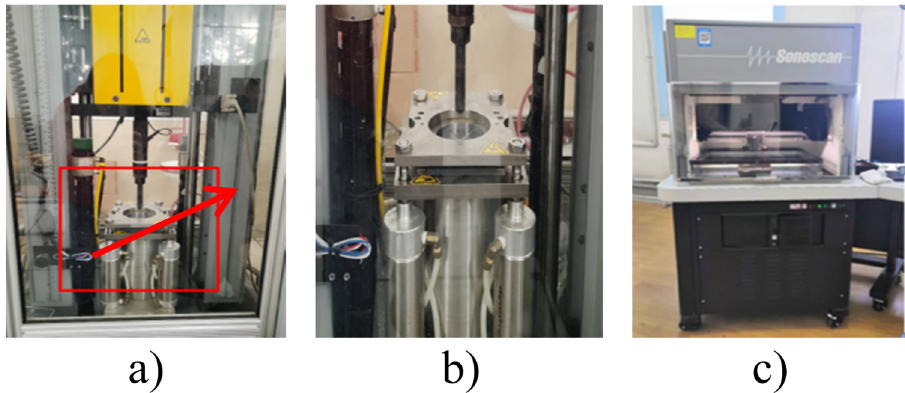
Figure 2: The test equipment, ( a ) impact testing machine, ( b ) pneumatic device for specimen, ( c ) ultrasound C scanner.